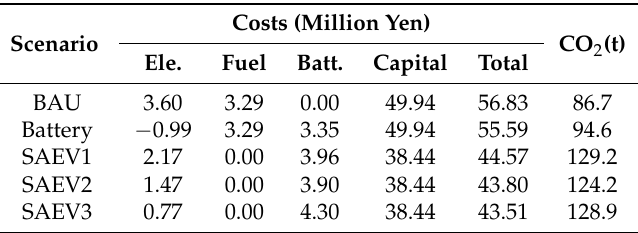
Figure 4. Weekly total costs for 100 iterations for each case considered. Table 6. Costs and emissions for VPP scenarios. Capital includes the cost of vehicles and solar